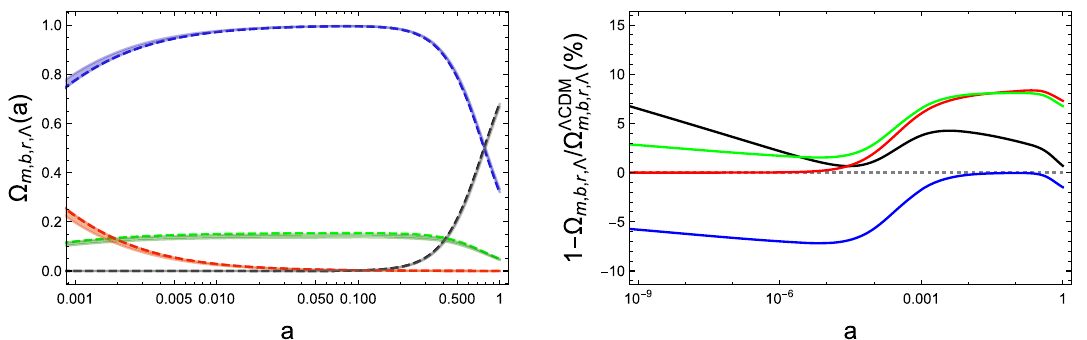
Fig. 1 Evolution with the time of dimensionless density parameters. (Left panel): matter (blue), baryons (green), radiation (red) and dark energy (black) for both full Bekenstein entropic model with (cid:4)( t ) = (cid:4) σ confidence levels as shaded regions) and full (cid:2) CDM (dashed 0 H (1